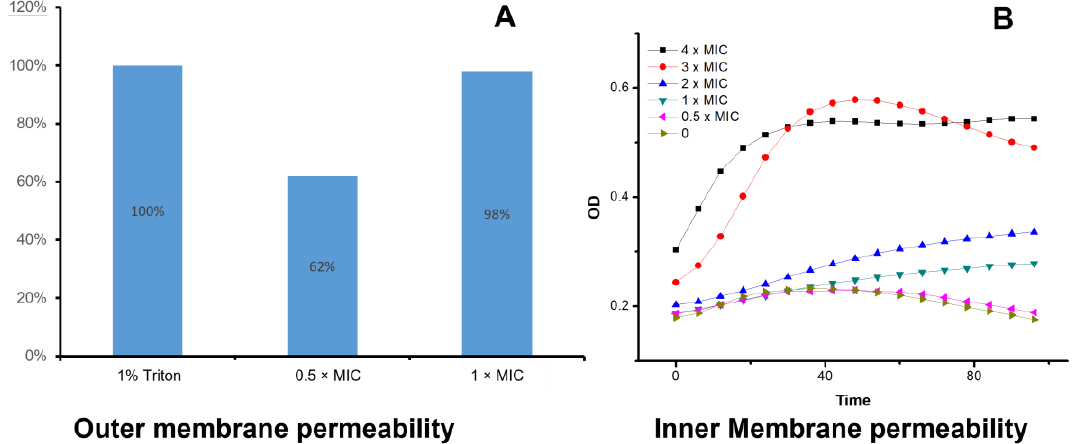
Figure 3. Outer membrane (OM) permeabilization ( A ) and inner membrane permeabilization ( B ) against E. coli .